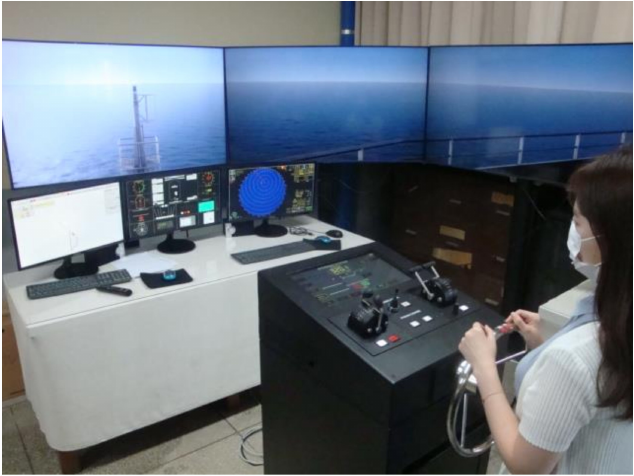
Figure 4. Scene of ship maneuvering simulation for observing the turning